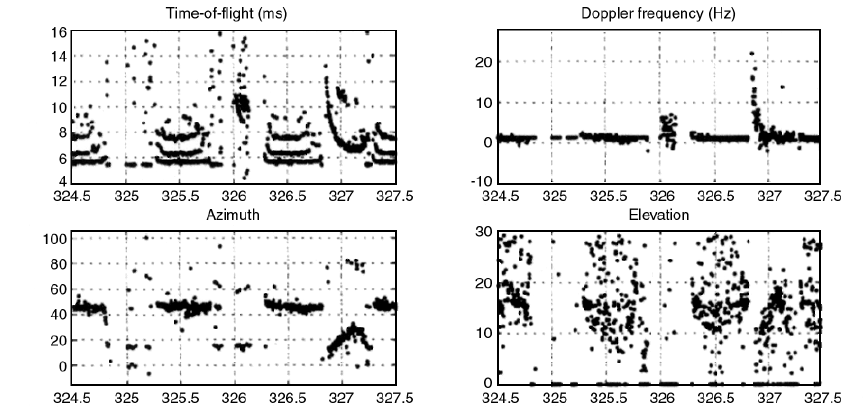
Fig. 8. Results from an HF direction-finding experiment between Uppsala to Leicester during a three-day pe- riod in November 2001. Note in particular the anomalous azimuthal directions of the received signals during the night of 326-327. From Warrington et al. (2002), reproduced by permission of the authors.